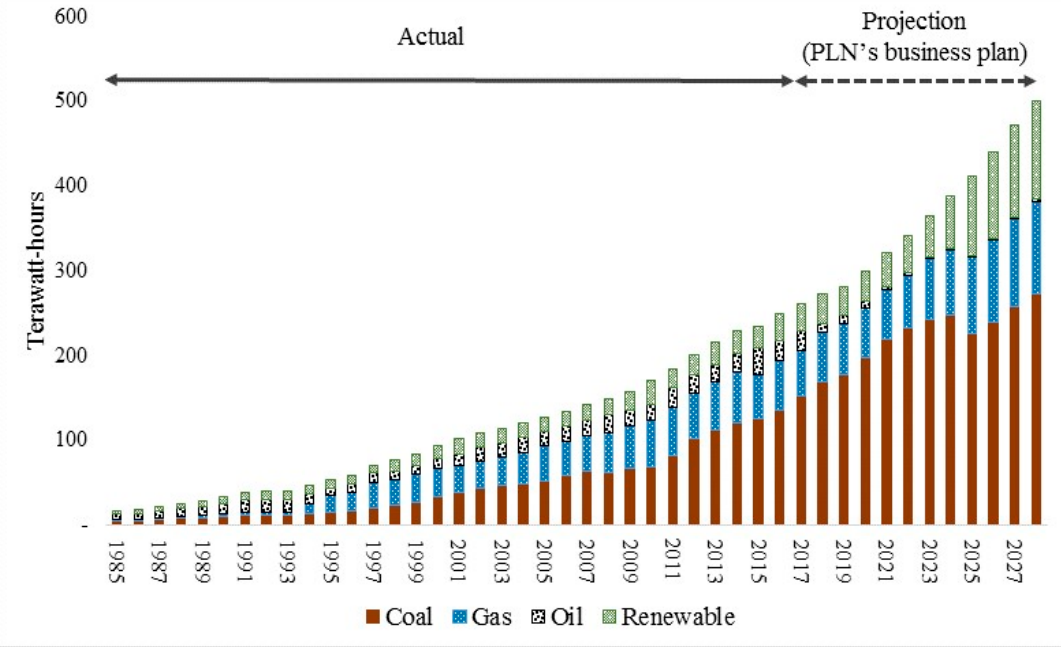
Figure 2. Shares of domestic coal consumption in Indonesia in 2016.